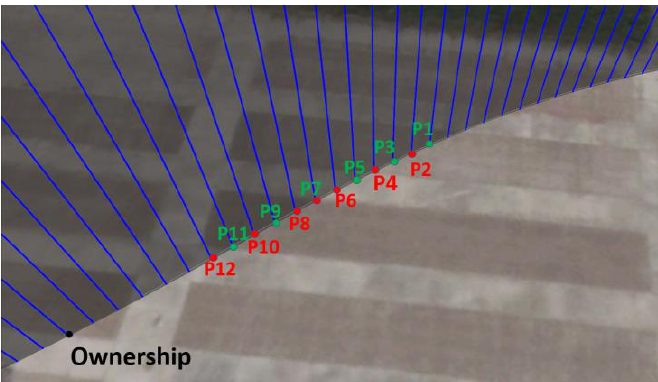
Figure 21. Measurements of global positioning system (GPS) data to evaluate the model in Experiment